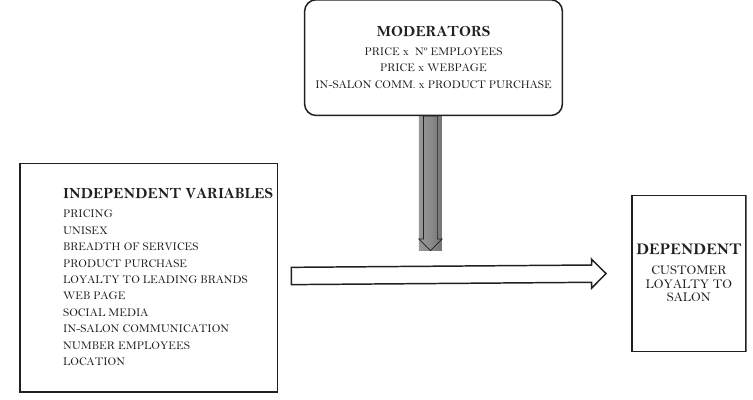
INDEPENDENT VARIABLES